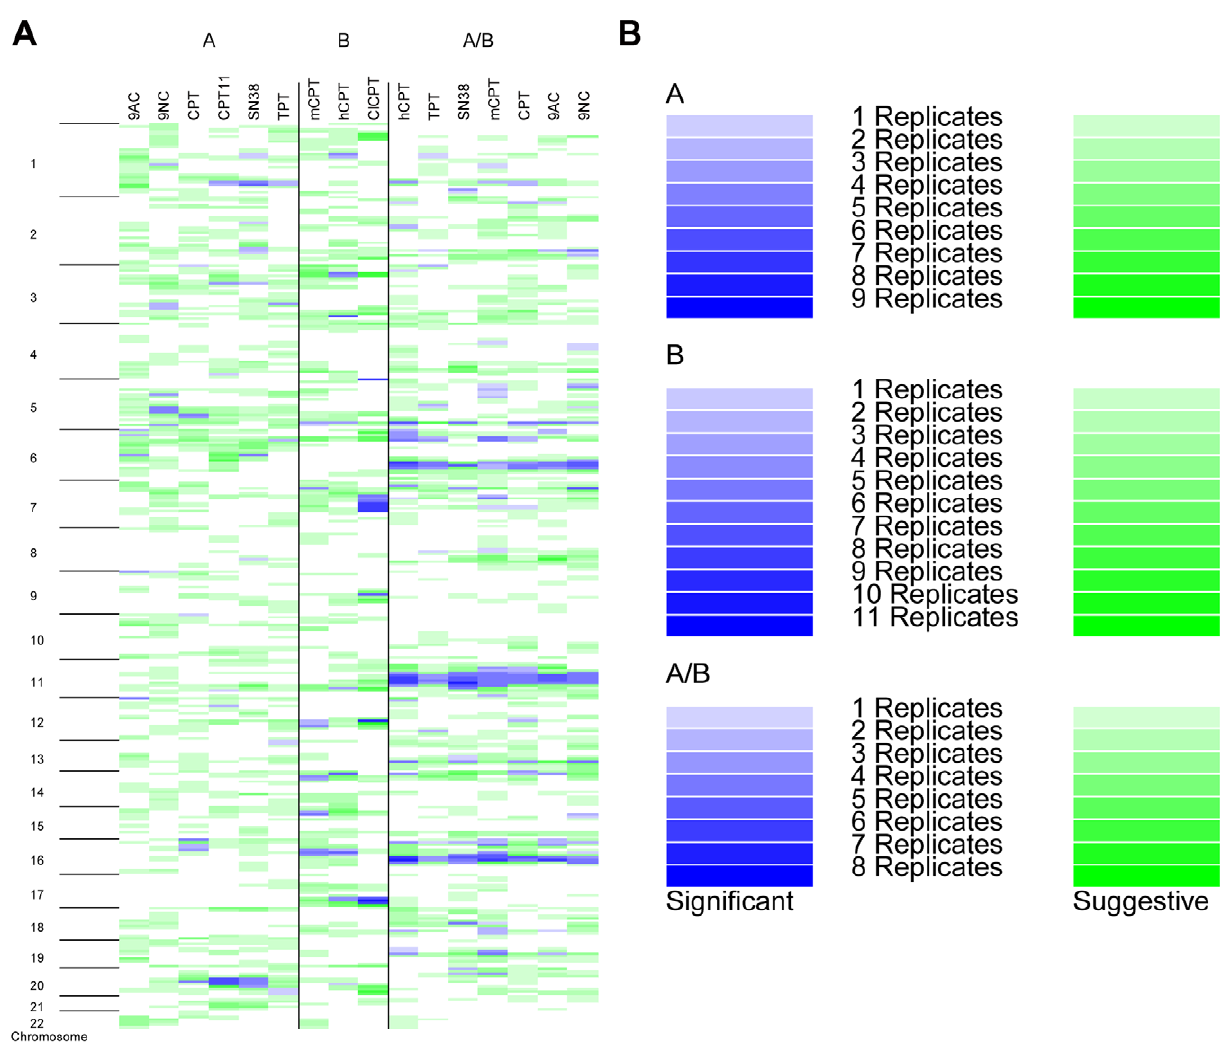
Figure 3. Genome wide pattern of QTLs for the camptothecins. A. Group A contains camptothecin analogues used in primary screen. Camptothecin analogues in Group B were used in the validation screen. Camptothecins in Group A/B were rerun from the primary and secondary screens. Each chromosome was partitioned into 10 cM regions. B. Each drug-dose combination that resulted in a significant QTL (LOD . threshold value) is indicated in blue. Intensity of the shading indicates the number of doses replicating that QTL at either the suggestive or significant level. Regions which also had a suggestive QTL (LOD . suggestive threshold) are indicated in green with color intensity referring to the number of doses replicating this